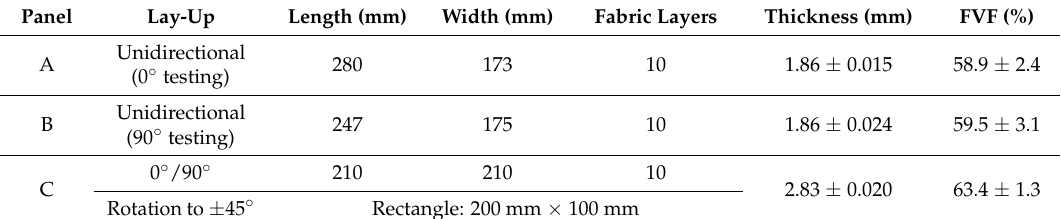
Table 15. Dimensions and lay-up of manufactured technological samples.